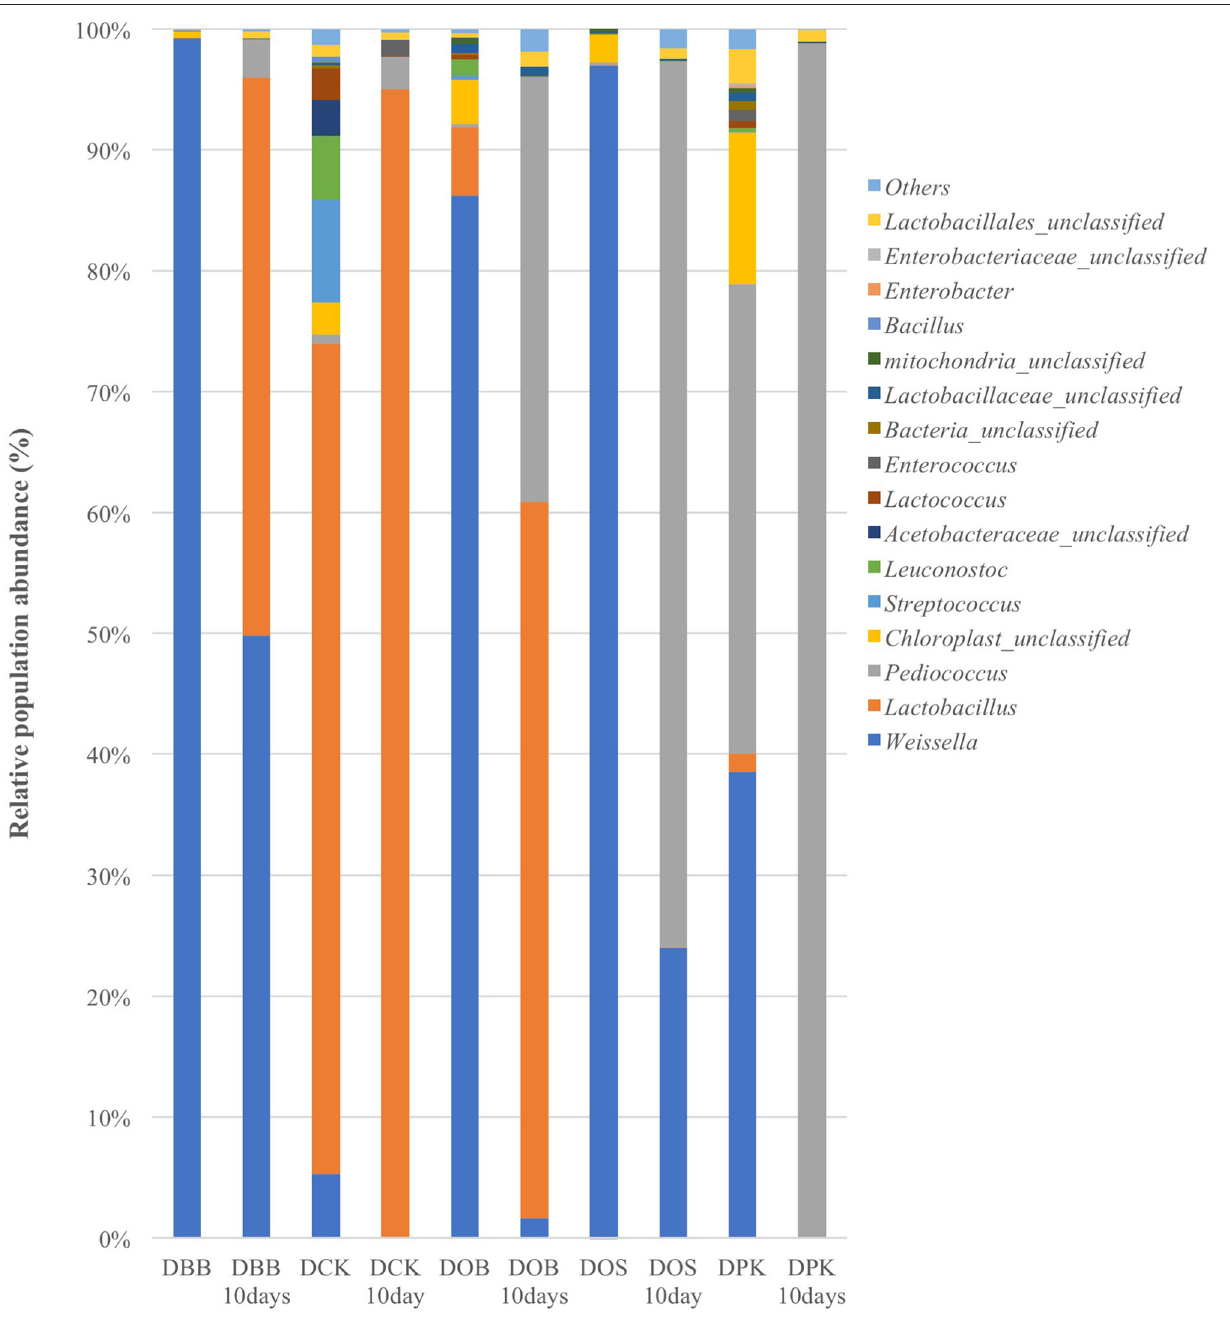
concentration in glucose reached a maximal value (from 300 to 550 mg/L) at the third day in all fermentation cases. After 8 days of fermentation, there was no more glucose except in the sample